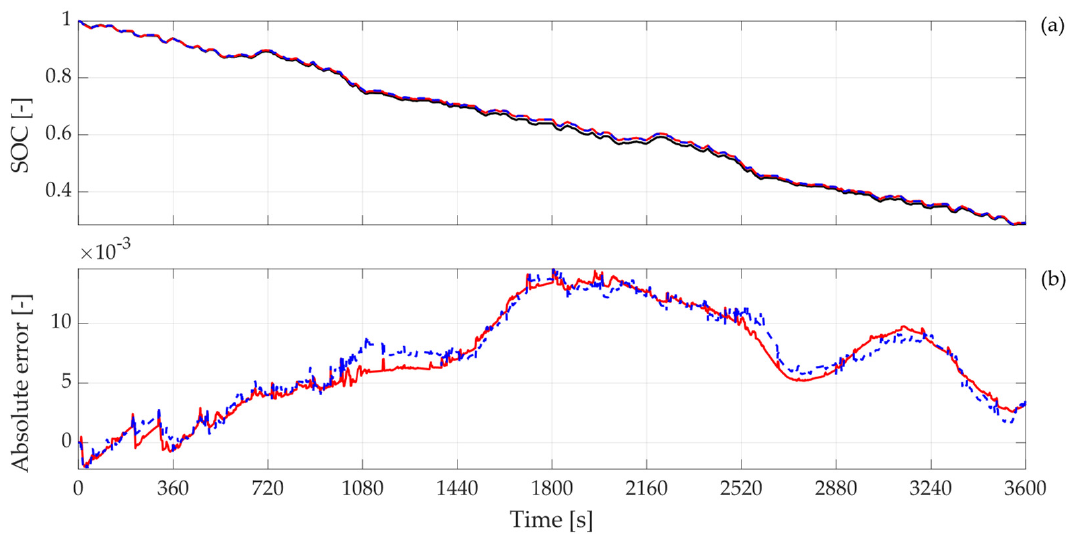
Figure 11. Results on testing dataset A—NARX RNN layout 1: ( a ) reference SOC (solid black line) vs. simulation estimated SOC (solid red line), HIL estimated SOC (blue dashed line) ( b ) simulation absolute error (red solid line), HIL absolute error (blue dashed line).